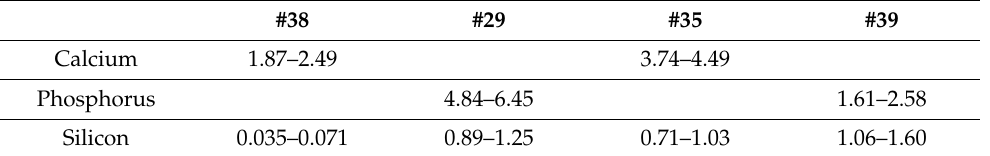
Table 3. Concentration of ion release at each time point after 24 h